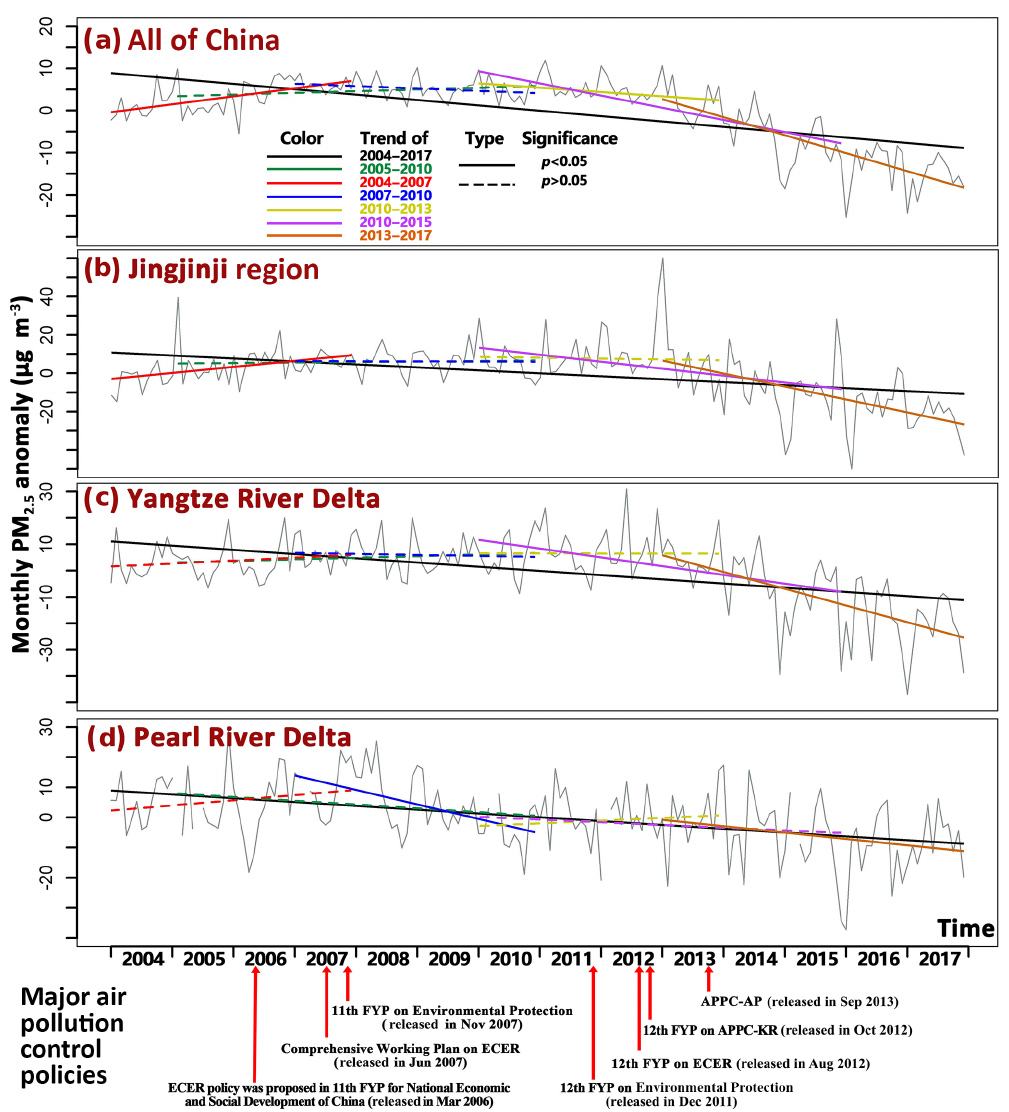
Figure 6. PM 2 . 5 trends for all of China and the Jingjinji, Yangtze River Delta (YRD), and Pearl River Delta (PRD) regions from 2004 to 2017, and corresponding air pollution control